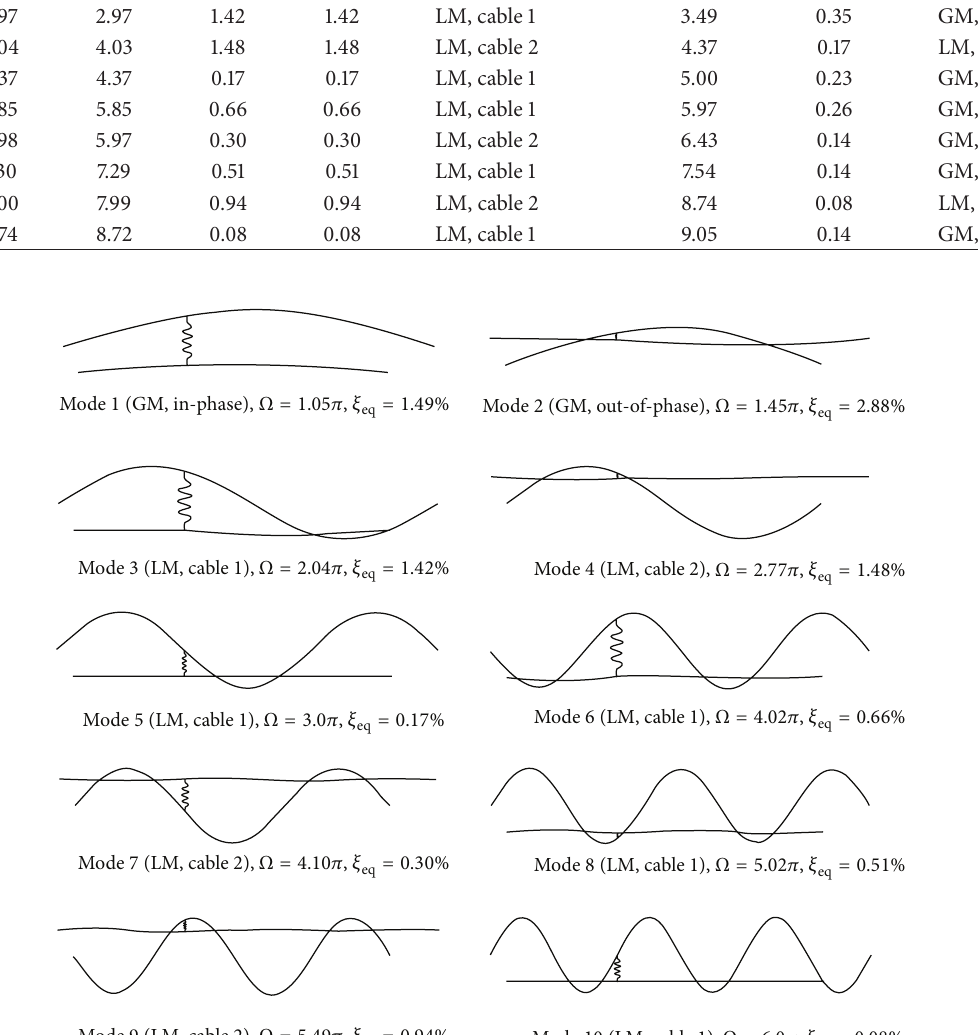
Figure 5: First ten modes of an asymmetric DMT two-cable network with a damped flexible cross-tie ( 𝐾 𝑐 = 30.54 kN/m, 𝐶 𝑐 = 1.0 kN ⋅ s/m) at 𝜀 = 1/3